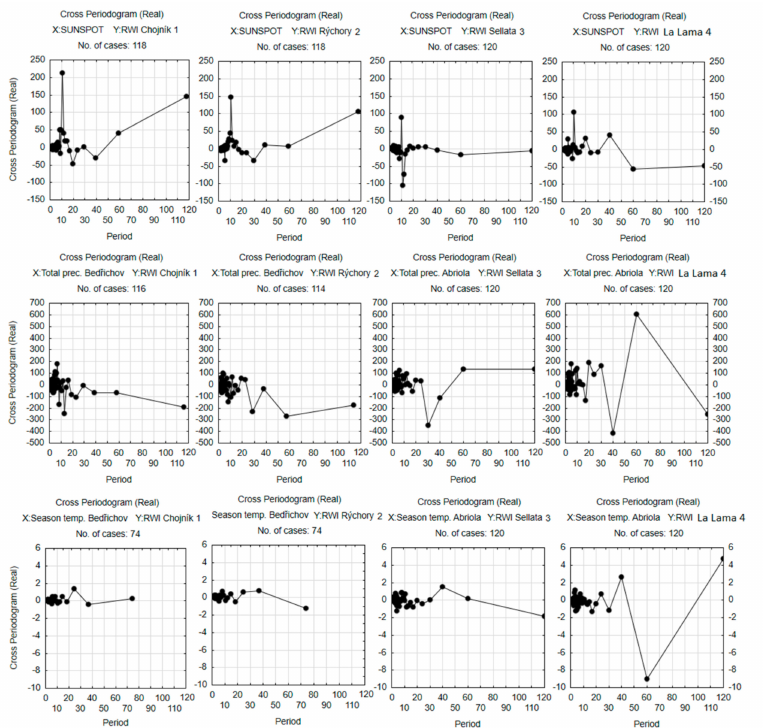
Figure 4. Cross-periodogram of ring width index (RWI) with sunspot number (SUNSPOT), annual precipitation (Total prec.) and seasonal temperature (Season temp.) in the whole time period,